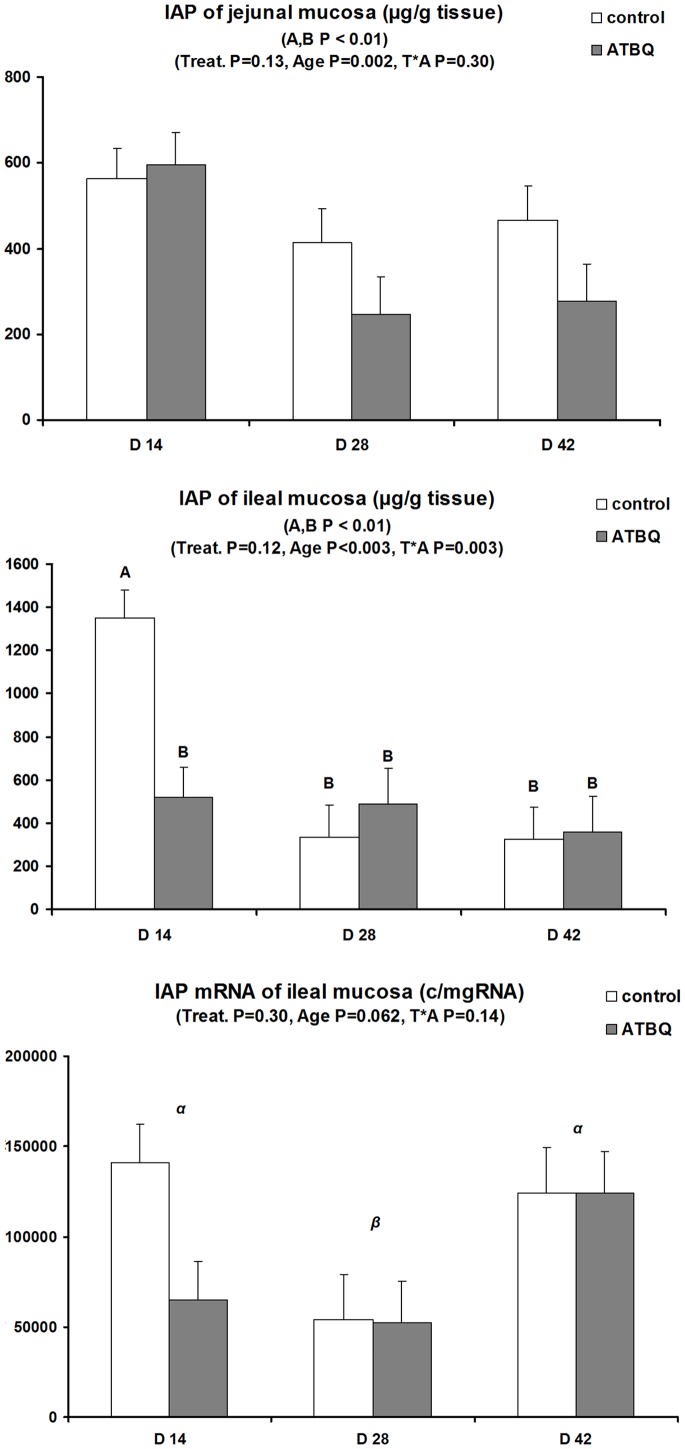
Intestinal alkaline phosphatase (IAP) concentration in jejunal and ileal mucosae and IAP mRNA expression in ileal tissue of offspring born to control or antibiotic-treated sows and slaughtered at different ages (LSmeans and SEM, n = 9–12 per treatment and age).Jejunal IAP was not influenced by treatments, but ileal IAP was transiently lower at day 14 (P<0.05) in offspring born to antibiotic-treated sows compared to controls (treatment by time interaction, P = 0.003). Differences in Ileal IAP mRNA levels did not reach significance, but ileal IAP concentrations and mRNA levels were positively correlated (P<0.01).